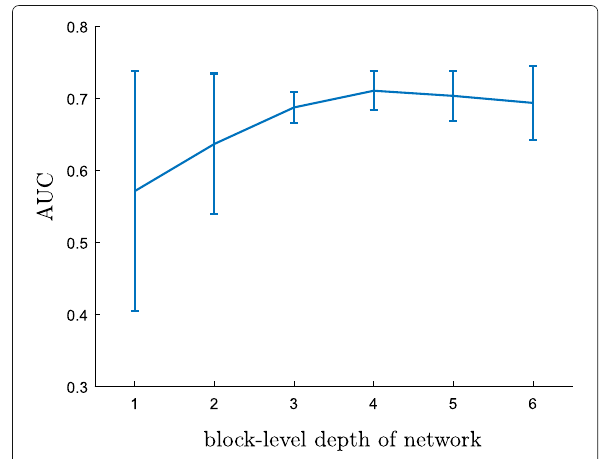
Fig. 7 AUCs estimated in our cross-validation stage with different choices of network